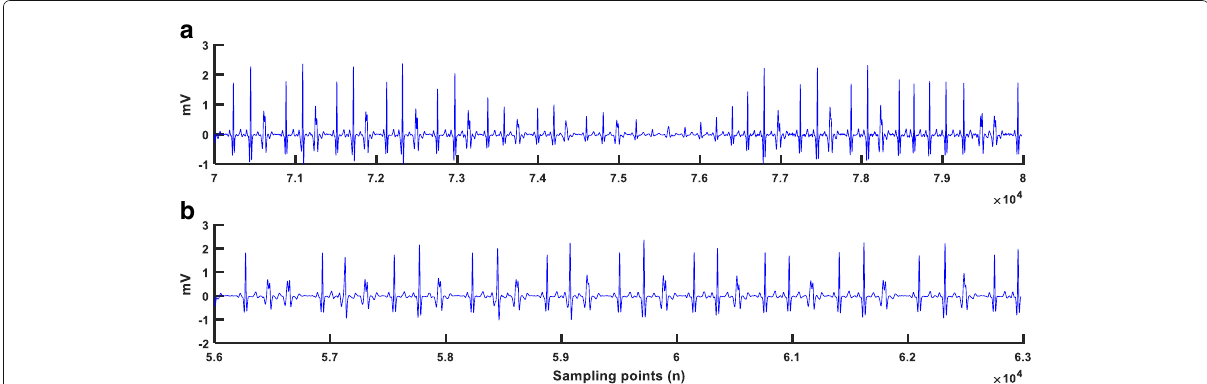
Fig. 3 Two typical characteristics of ECG signals. a General change tendency of QRS complex which the overall waveform is small or large in succession. b The change tendency of individual which will appear similar amplitude QRS complex locally